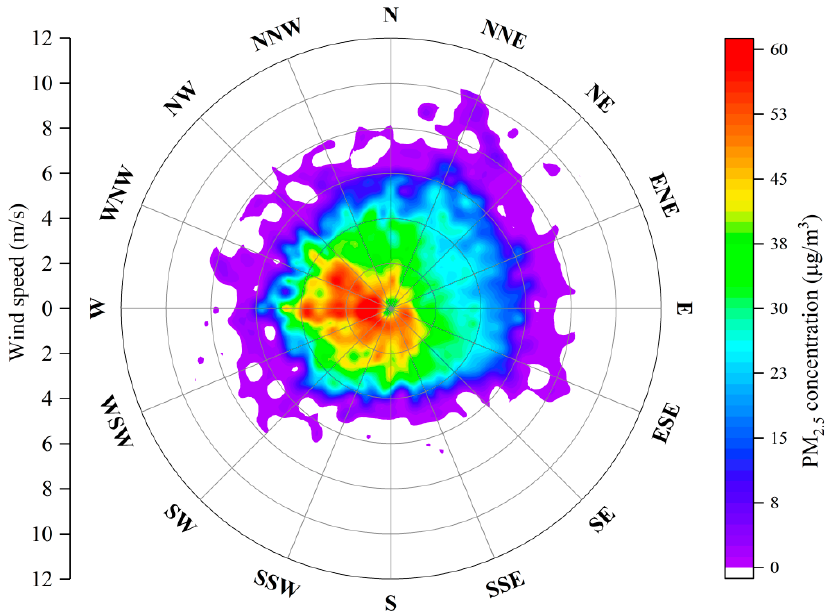
Figure 6. PM 2.5 concentration under different wind speed and direction.